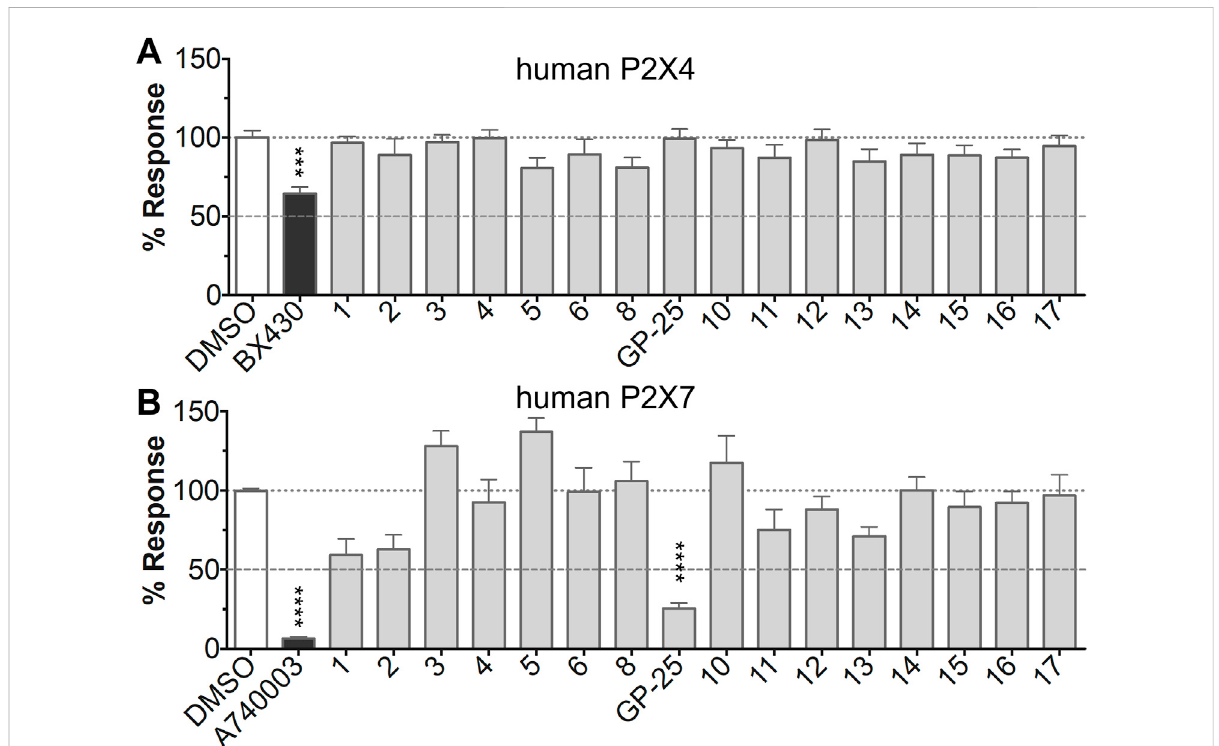
FIGURE 1 InitialscreeningofcompoundsathumanP2X4andhumanP2X7. (A) Normalized%responseof1321N1astrocytomacellsstablytransfectedwith human P2X4 to 1.2 µM ATP (Fluo-4 calcium uptake assay) incubated in the absence (DMSO) or presence of either 2 µM BX-430 or 10 µM Specs compound (1 – 16; GP-25 is compound 9). (B) Normalized % response of 1321N1 astrocytoma cells stably transfected with human P2X7 to 300